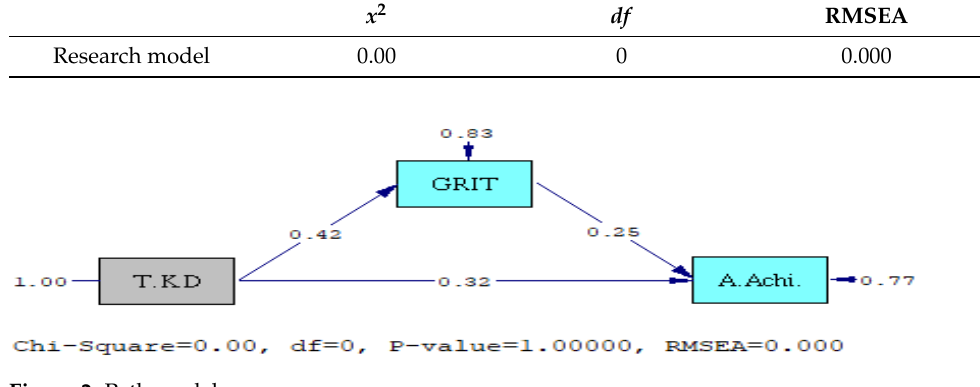
Figure 2. Path model.